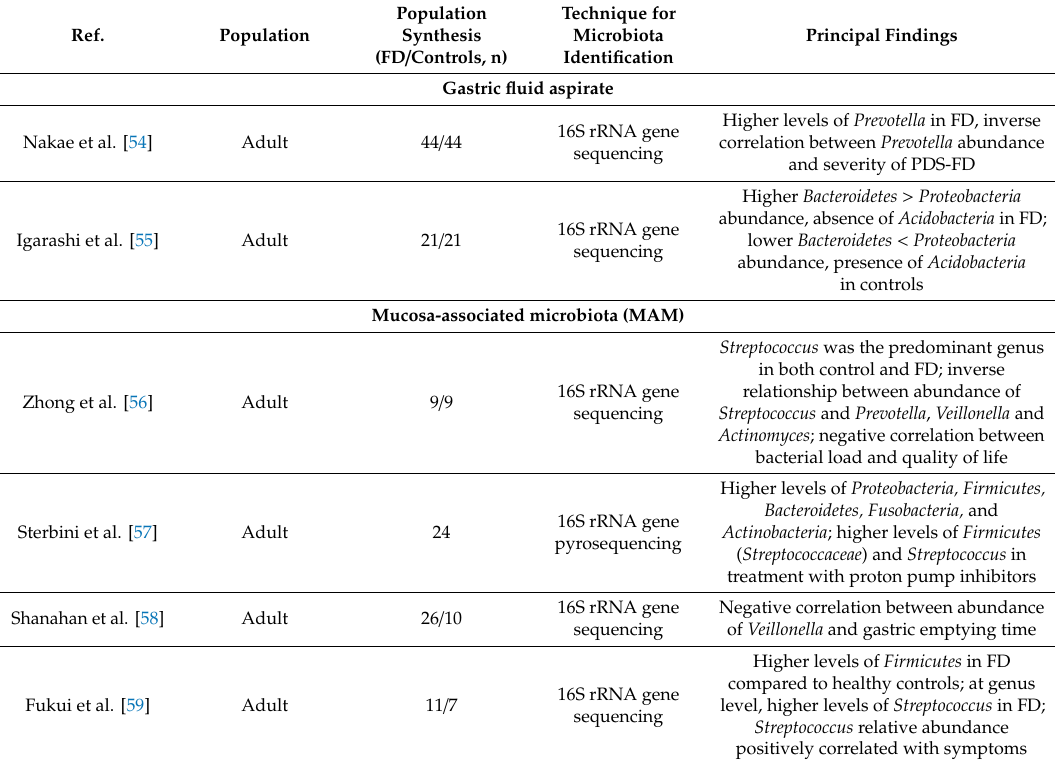
Table 1. Microbiota analysis studies in Functional